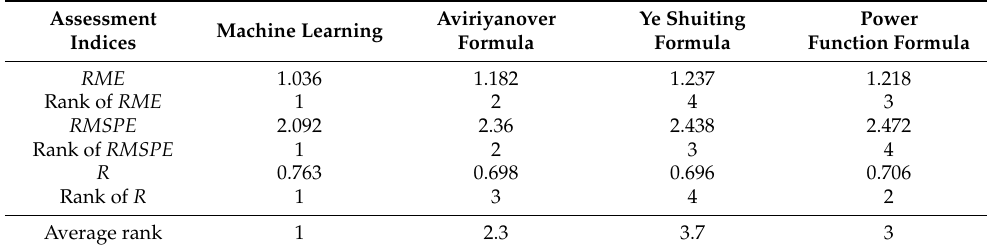
Table 6. Analysis of the assessment indices for machine learning and formulae